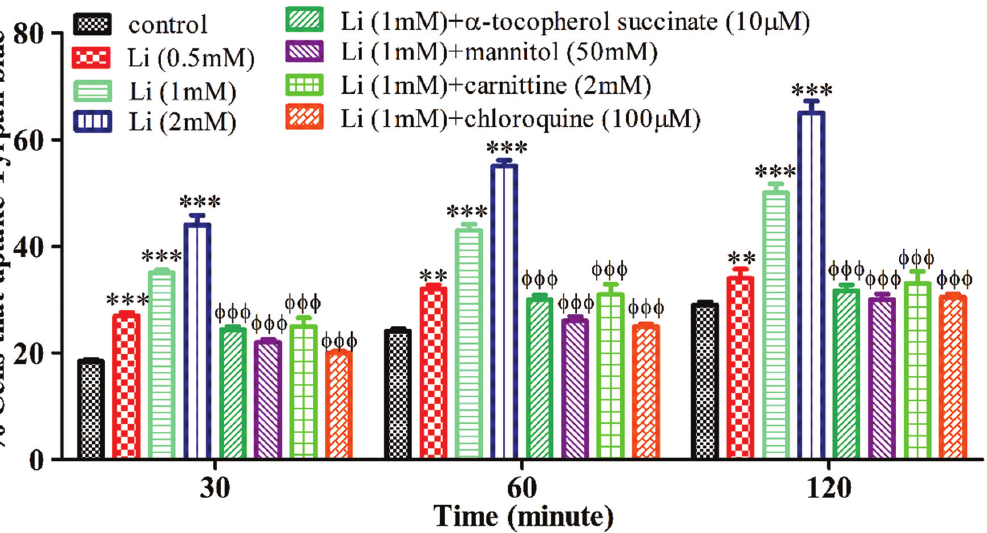
Figure 1: Effect of different concentrations of Li on neuronal death using primary neuronal cortical culture. Determination of cytotoxicity was done as the percentage of cells that absorb trypan blue. Values are shown as mean ± SD of three separate experiments (n = 3). ** p < 0.01, *** p < 0.001, significant difference in comparison with non-treated neurons (control). ɸɸɸ p < 0.001, significant difference in comparison with Li (1 mM)-treated neurons.